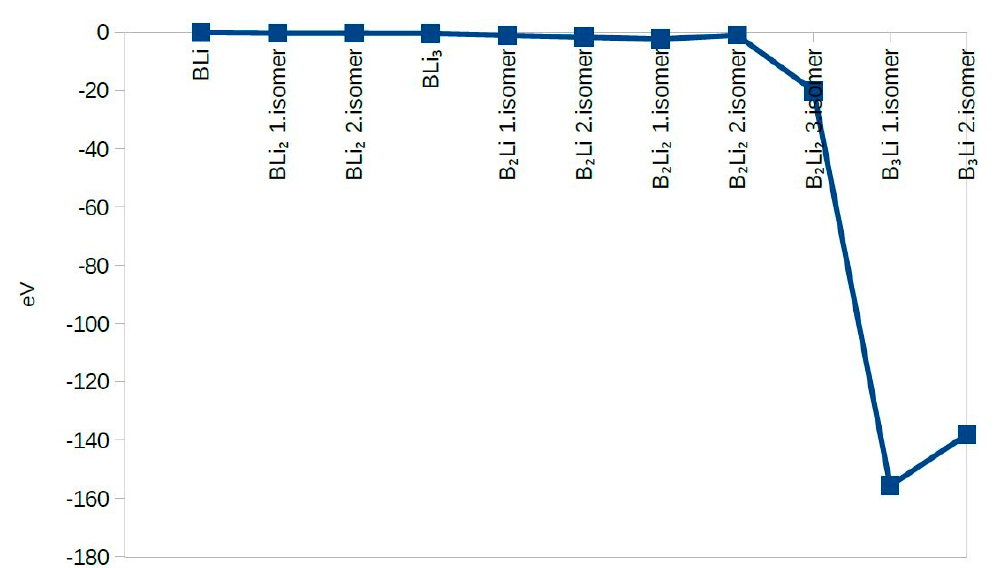
Figure 7. Dissociation Energy.